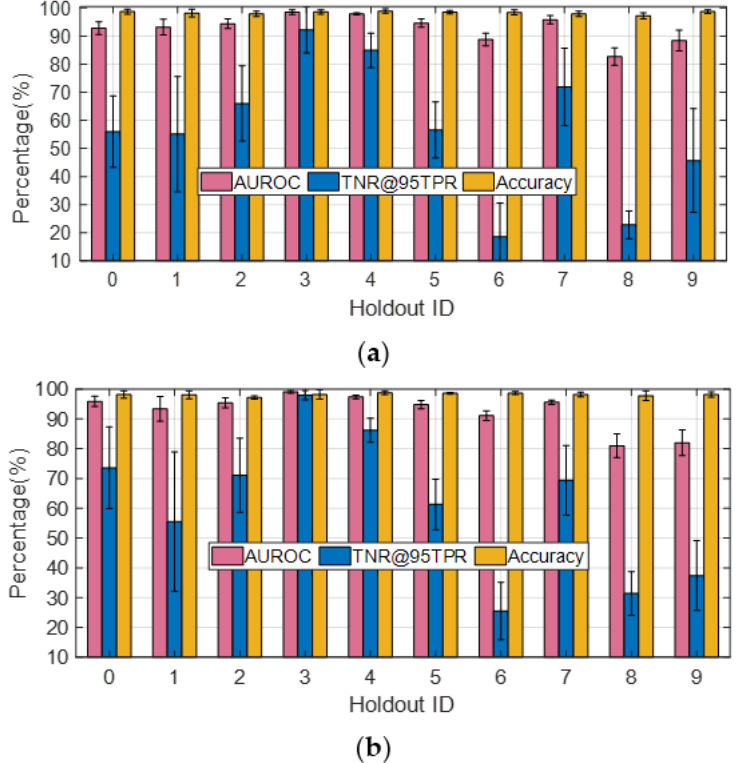
Figure 10. Effect of holdout class choice on detection statistics ( K = 0.1, J = 1). ( a ) OE training dataset #1; ( b ) OE training dataset #2. #1; ( b ) OE training dataset